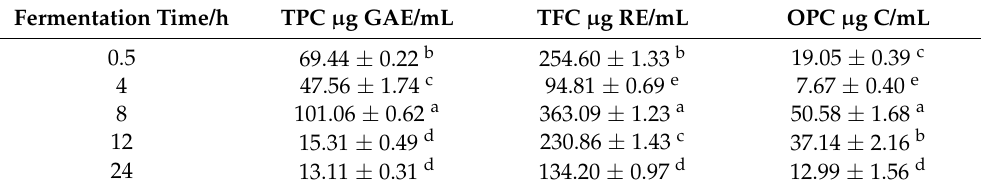
Table 1. Changes in the total phenol, total flavonoid, and procyanidin contents during in vitro